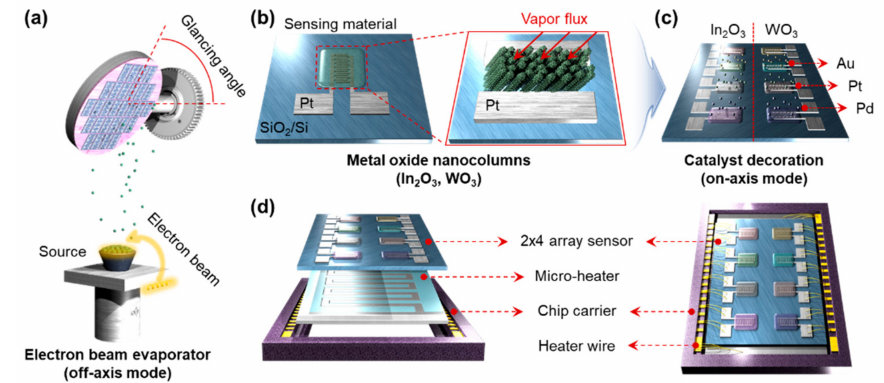
Figure 1. Schematic illustration of ( a ) the fabrication procedures for porous nanostructures using GAD. ( b ) A design of Pt-IDEs and metal oxide nanorods grown the direction of the vapor flux. ( c ) The position of Au, Pt, and Pd catalysts decorated by e-beam evaporator using on-axis mode. ( d ) 2 × 4 sensor array with 2 × 4 sensor array, back heater, chip carrier, and Au